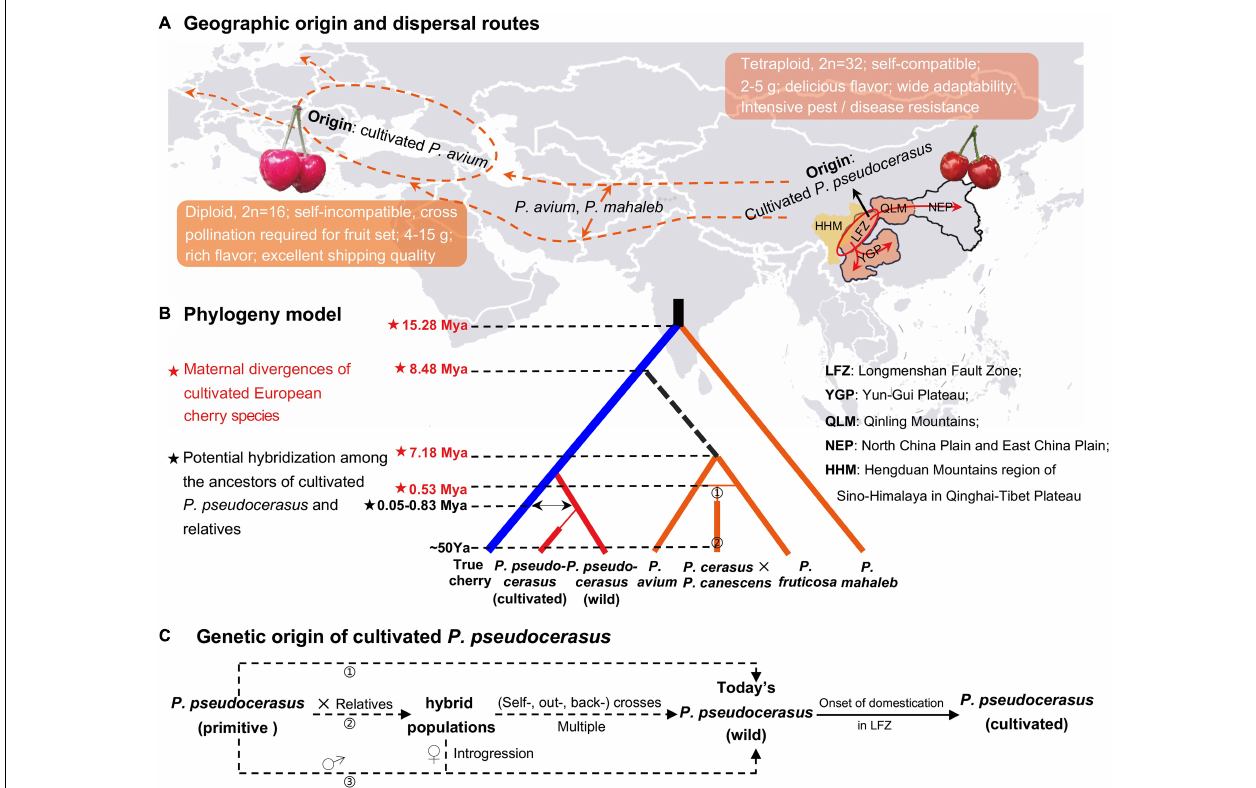
FIGURE 6 | Evolutionary model and demographic history of the fruiting cherry. (A) Geographic origin and dispersal routes of Prunus pseudocerasus , P. avium, and P. mahaleb . In the world map, orange dotted line represented the putative dispersal route of P. avium and P. mahaleb , which inferred from their extant distribution (Faust et al., 2011) and ancestral area construction analysis (Chin et al., 2014). Ovals stood for the geographic origin of cultivated P. avium and P. pseudocerasus . Red arrows represented the possible dispersal routes of the cultivated P. pseudocerasus, which were inferred from whole plastomes (this study), nuclear SSRs (Zhang et al., 2018), intergenic and intronic chloroplast deoxyribonucleic acids (cpDNAs), and internal transcribed spacers (ITS) (Chen et al., 2015). (B) Phylogeny of five cherry species. This model was generated according to the present phylogenomic analyses ( Figure 3 and Supplementary Figures 7–13 ), and divergence times were from the molecular dating ( Figure 4 and Table 4 ) and reported studies (Gruppe, 1985). (cid:192) and (cid:193) presented the genetic origin of P. cerasus and P. cerasus × P. canescens (Gisela 5). Mya, million years ago; Ya, years ago. (C) Genetic origin of cultivated Chinese cherry ( P. pseudocerasus ). Dotted arrows represented three putative paths. In the first path ( (cid:192) ), no gene introgression happened between partial primitive P. pseudocerasus and other Cerasus taxa. In the second path ( (cid:193) ), multiple hybridization events probably produced numerous interspecific hybrid populations, within and between of which self-, out-, and back-crosses subsequently happened. In the third path ( (cid:194) ), it is also possible that primitive P. pseudocerasus